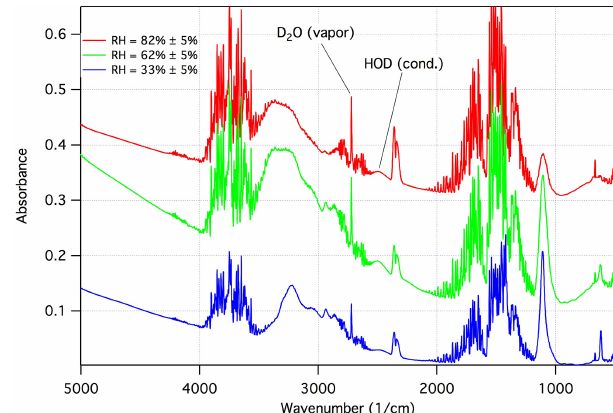
Figure 5. (NH 4 ) 2 SO 4 / 1,2,6-hexanetriol solution exposed to D 2 O at three different RH values. Note the presence of features related to D 2 O: the D 2 O vapor features at 2600–2800cm − 1 and the con- densed HOD feature at 2500cm − 1 . HOD is present in all three spectra, indicating that gas-phase diffusion occurred despite phase separation. Note that the green spectrum, taken at 62% RH, has a higher aerosol concentration than the other cases, resulting in the enhanced scattering slope at higher